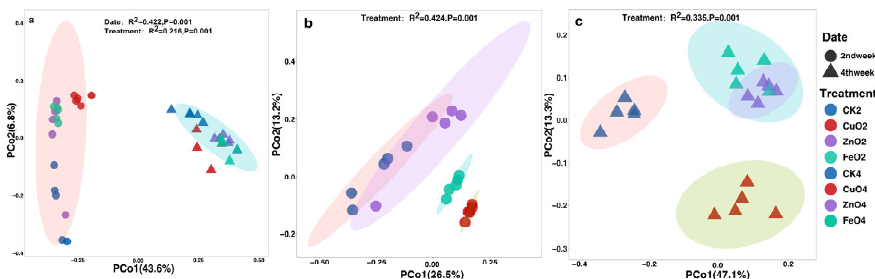
Figure 4. PCoA (principal coordinates PCo1 and PCo2) analysis of the bacterial communities based on the Bray–Curtis distance ( a ) PCoA analysis of all samples, ( b ) PCoA analysis of samples in the second week ( c ) PCoA analysis of samples in the fourth week ( p < 0.05, permutational multivariate analysis of variance (PERMANOVA)). Abbreviation: 2nd week of nanoparticles treatment (Control 2 , CuO 2 , ZnO 2 , and FeO 2 ), 4th week of nanoparticles treatment (Control 4 , CuO 4 , ZnO 4 , and FeO 4 ).